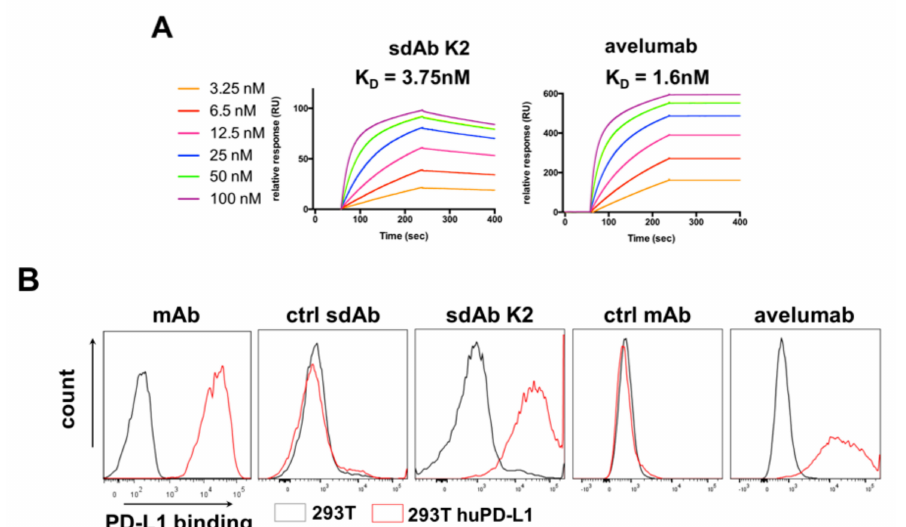
Figure 1. Characterization of sdAb K2, a sdAb that specifically binds to human PD-L1. ( A ) Representative sensograms showing the a ffi nity / kinetics of di ff erent concentrations of purified sdAb K2 or avelumab, interacting with immobilized recombinant human PD-L1 protein, as determined in surface plasmon resonance (SPR). ( B ) Representative flow cytometry histograms showing labeling of PD-L1 NEG (grey) versus PD-L1 POS (red) 293T cells with mAbs specific for PD-L1, ctrl sdAb (sdAb R3B23), sdAb K2, control mAb (isotype-matched) or avelumab. 2.2. sdAb K2 Generates Strong Positive Contrast in Xenograft Tumor Models Using SPECT / CT